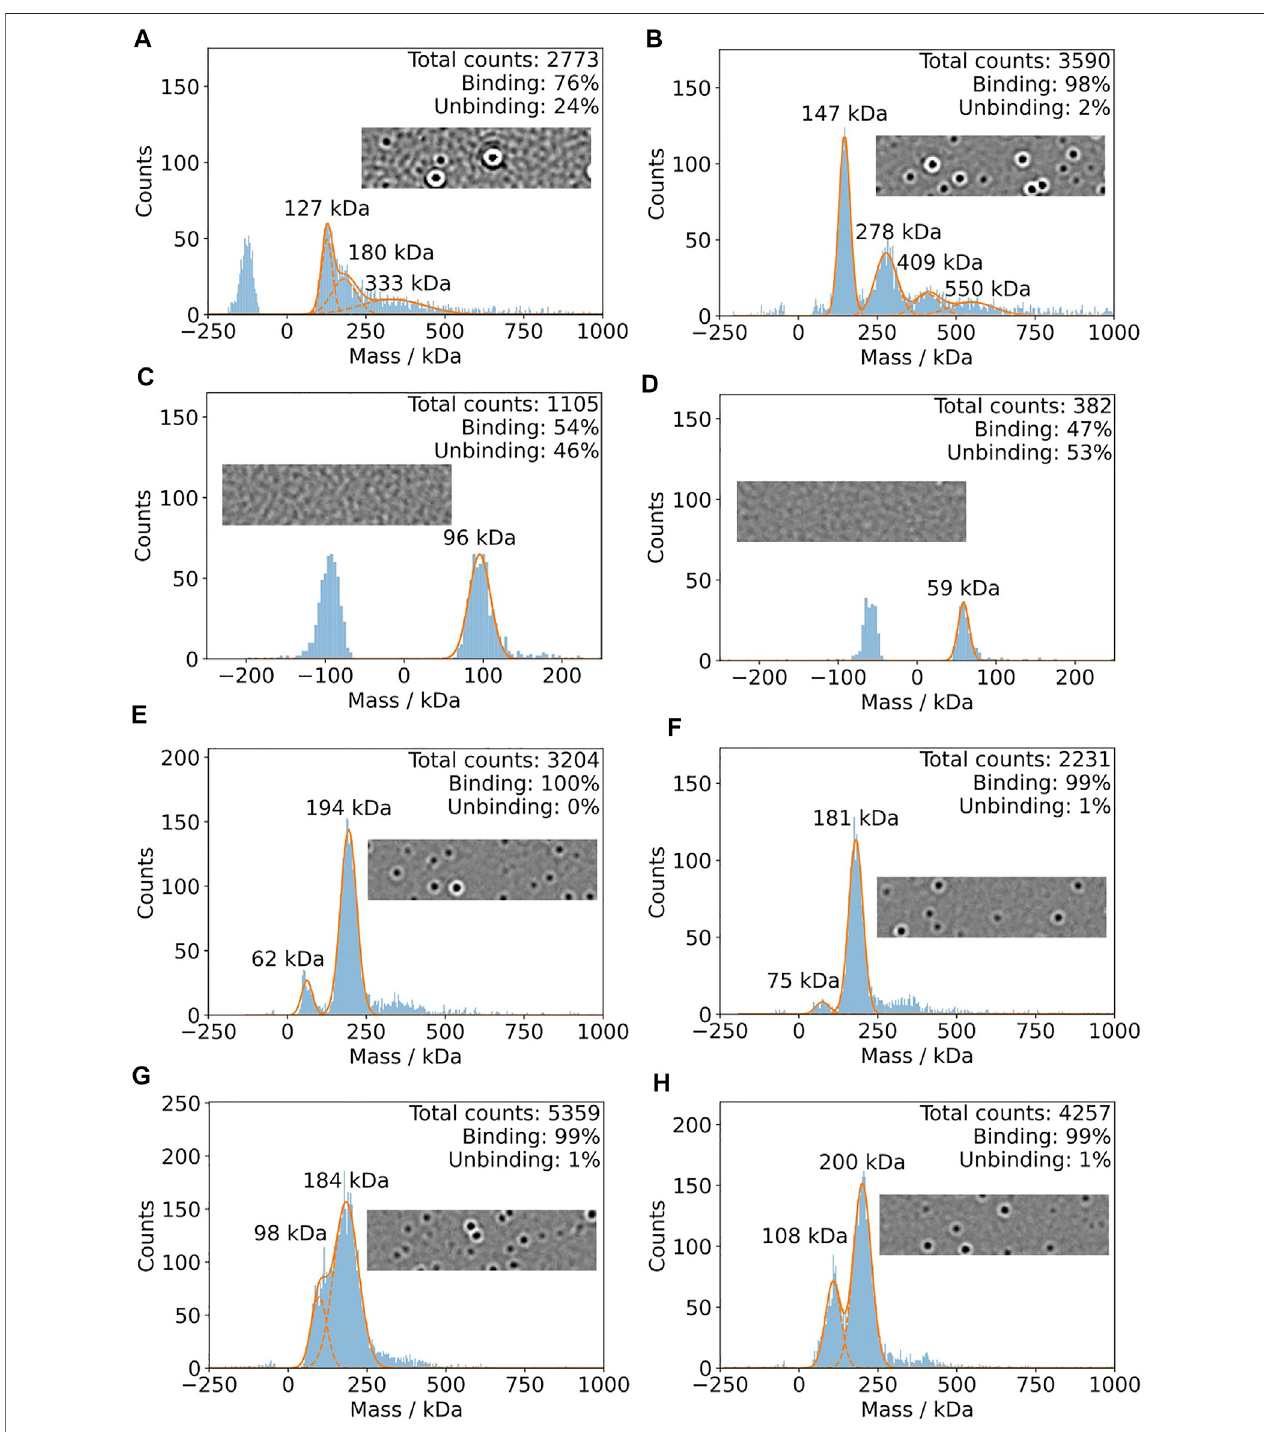
FIGURE 5 | Mass photometry of IJ1. For each experiment, 0.5 ul of pre-dilution was added to 19.5 detergent-free buffer on the mass photometry slide. (A) Measurement using a protein pre-dilution with 0.036% DDM. The fi nal DDM concentration is 0.0009% and 40 nM protein. (B) Pre-dilution of protein solution into detergent-free buffer results in a DDM concentration of 0.006%. The fi nal DDM concentration is 0.00015% and 80 nM protein. (C,D) Control experiments using similar DDMconcentrationsandnoprotein. (C) 0.03%DDM. (D) 0.003%DDM. (E) and (F) showthemasshistogramsforIJ1inthepresenceofdifferentconcentrationsof LMNG as detergent at a fi nal protein concentration of 40 nM. Since the protein was concentrated, we can only give estimations for the fi nal LMNG concentrations: 0.00004%forpanelEand0.000015%forpanels (F) , (G) ,and (H) .AmphipolsolubilizedIJ1attwodifferentpre-dilutionconcentrations: (G) 3.2 uMIJ1and0.0042%A8- 35. (H) 1.6 uM IJ1 and 0.0021% A8-35. The fi nal protein concentrations were 80 nM (G) and 40 nM (H) .